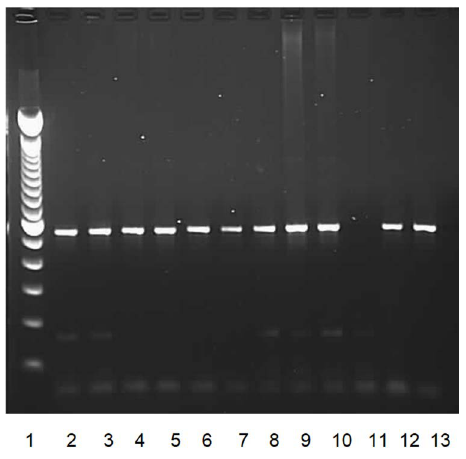
Table 1. Comparison between cefpodoxime screening test and the combined disc test results.